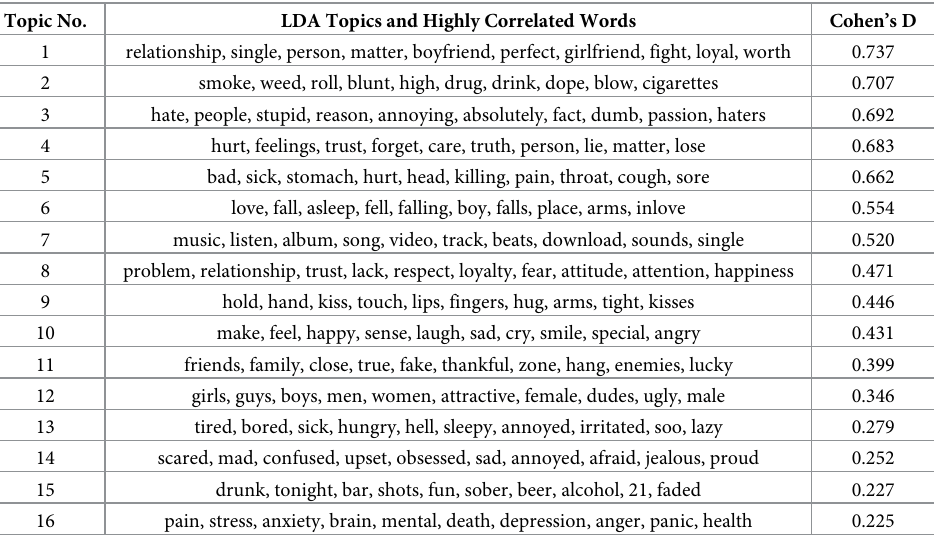
Table 6. Results from LDA analysis for male: 18—22. Topic No. LDA Topics and Highly Correlated Words